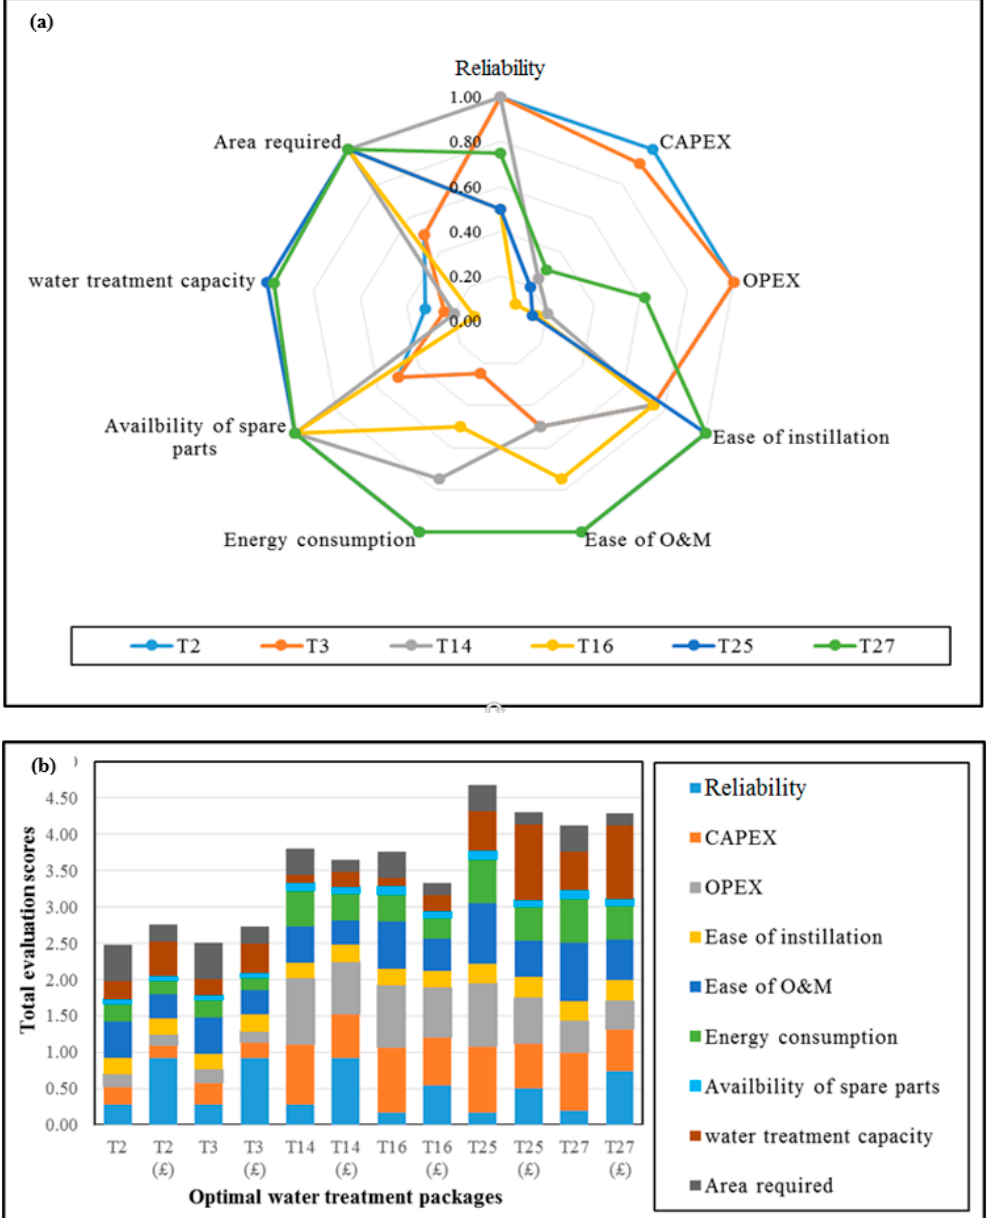
Figure 5. Results on Scenario 4—the effect of income in the selection of packaged drinking water treatment systems: ( a ) Criteria / objective contribution star chart; ( b ) Stacked column on performance of water treatment systems; technologies with ‘(£)’ represent the evaluation results in families with high income (Scenario 4b).